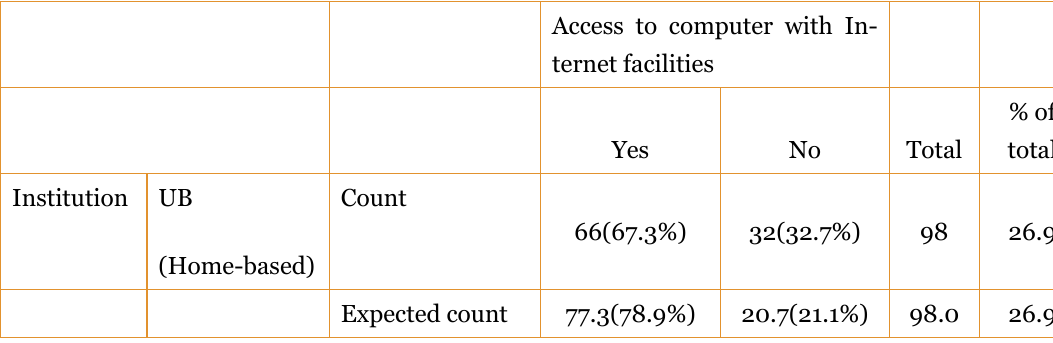
Access to computer with In- ternet